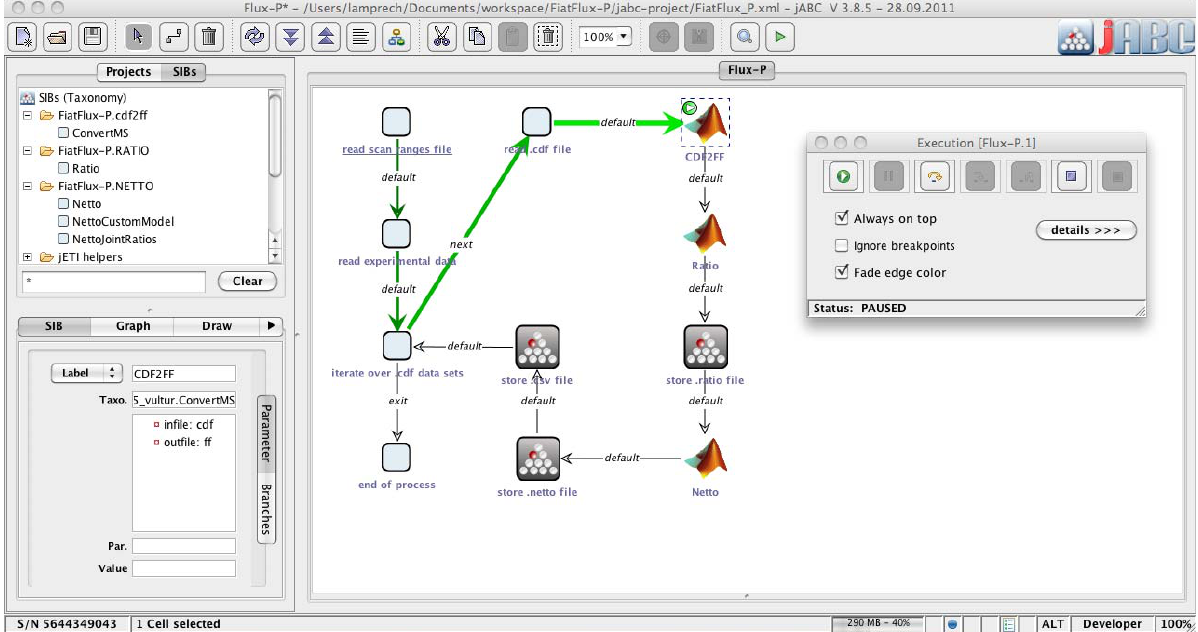
Figure 2. Bio-jETI GUI. The jABC framework, which provides the graphical user interface for Bio-jETI, supports the orchestration of processes from heterogeneous services. Workflow models are constructed graphically by placing process building blocks from a library (top left) on a canvas (center) and connecting them by labeled branches to define the flow of control. The models are directly executable by an inbuilt interpreter component